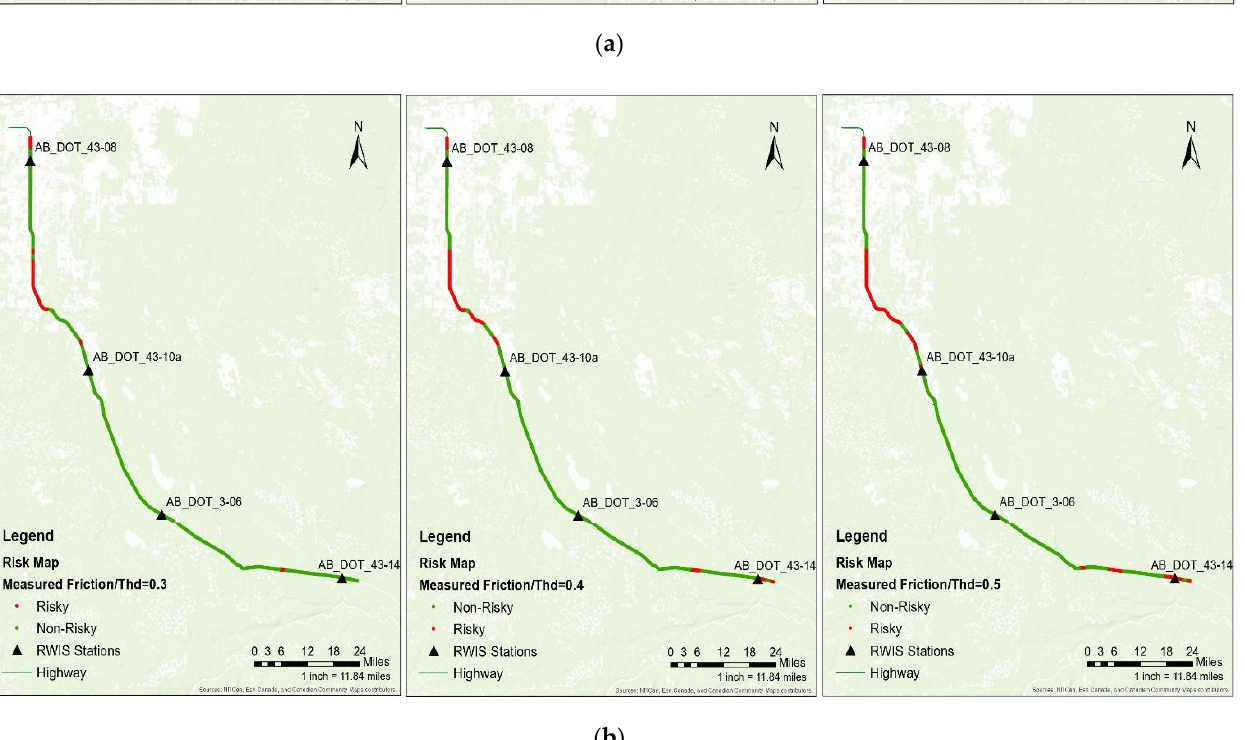
Figure 9. Road risk maps at Threshold = 0.3, 0.4, and 0.5. ( a ) Risk maps based on predicted friction; ( b ) Risk maps based on measured friction.